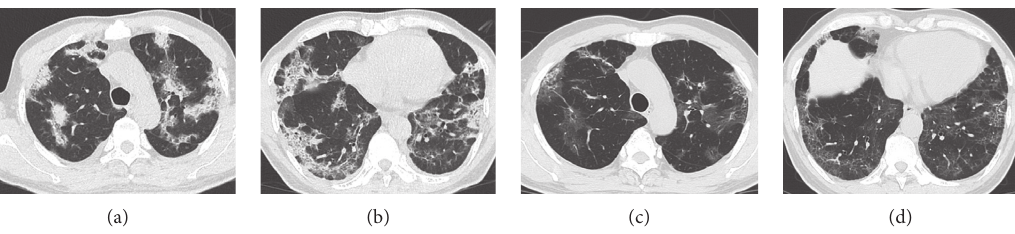
Figure 3: A 55-year-old male patient with a severe case of COVID-19. (a, b) Consolidations and ground-glass opacities were seen in multiple lobes and segments of both lungs on day 25 after onset of the disease. The density was not uniform, and there was an evidence of air bronchograms and intralobular septal thickening. (c, d) On day 47 after onset and day 21 after discharge, ground-glass opacities and fibrous strip shadows were seen in multiple lobes and segments of both lungs. Consolidations dissipated and the intralobular septal thickening was milder compared to the last CTof admission. The total volume of pulmonary lesions was measured and calculated through two CTscans, and the pulmonary lesions were dissipated to a slight